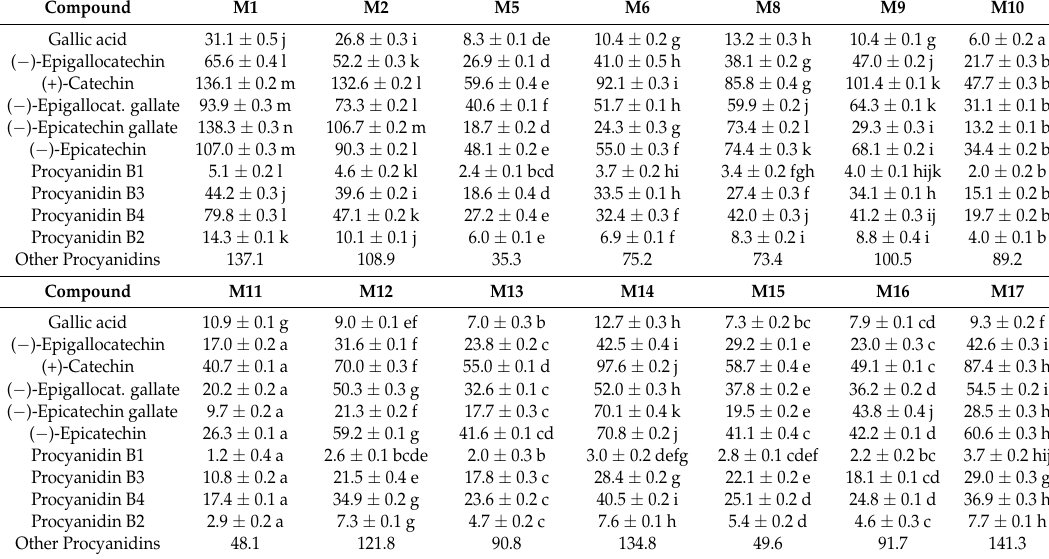
Table 5. Gallic acid, flavanols and oligomeric proanthocyanidins content of berry seeds (mg/kg of grape, expressed as (+)-catechin). Values represent mean of three replicates ± SD. a, b, c: the means that do not bear a common letter differ significantly at the 0.05 level of